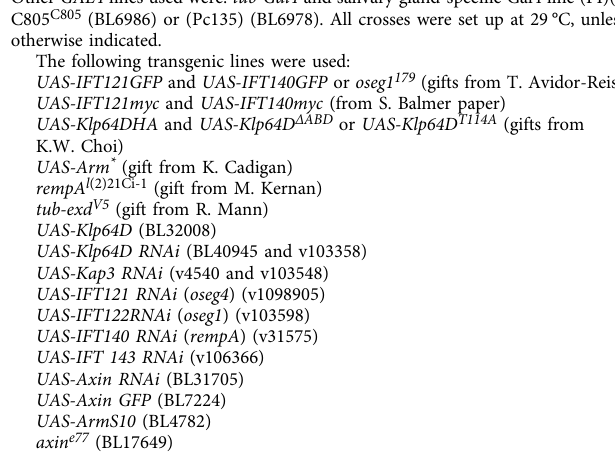
Other GAL4 lines used were: tub-Gal4 and salivary gland-speci fi c Gal4 line (PI)(2) C805 C805 (BL6986) or (Pc135) (BL6978). All crosses were set up at 29 °C, unless otherwise indicated. The following transgenic lines were